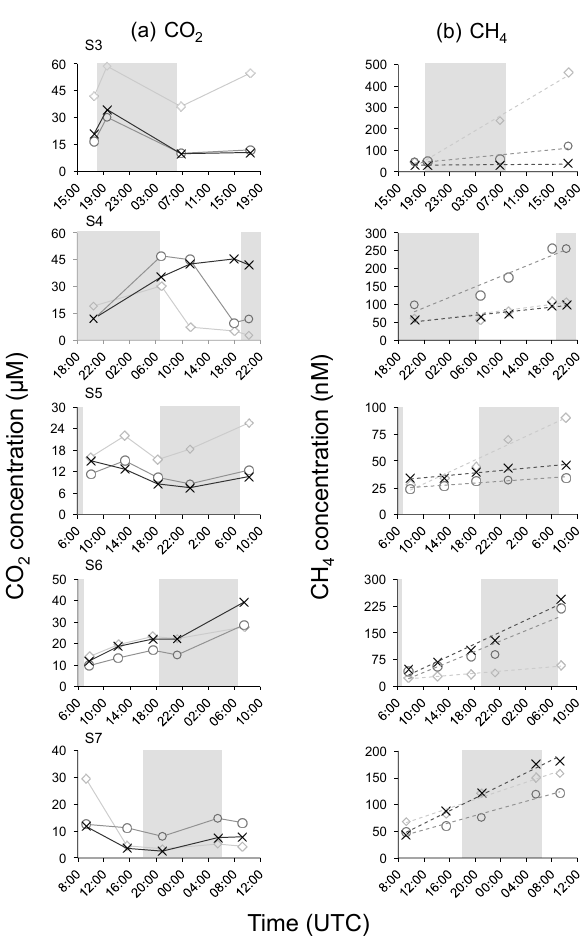
Figure 2. Change in CO 2 (a) and CH 4 (b) concentrations over time in triplicated mangrove sediment cores from mangrove stations S3– S7. Shaded areas represent night-time and each replicate is coded by different symbols.